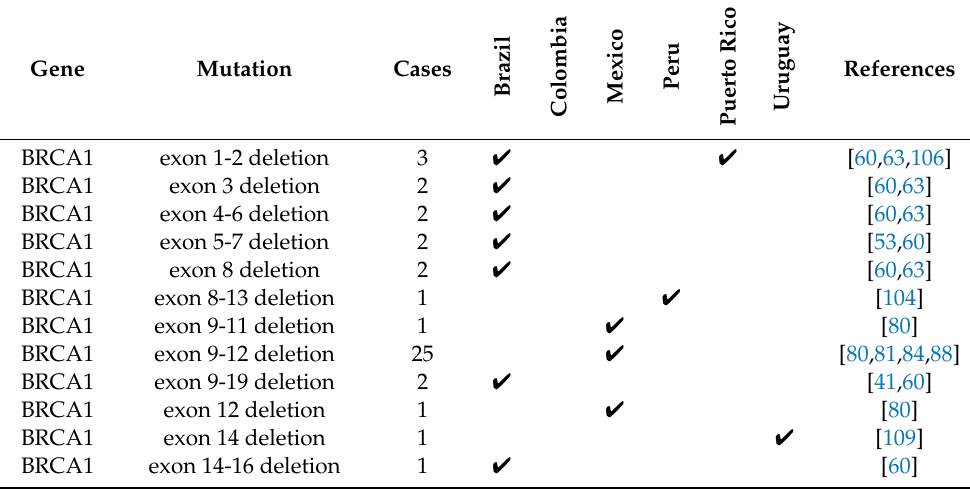
Table 4. Large genomic rearrangements in BRCA1 /